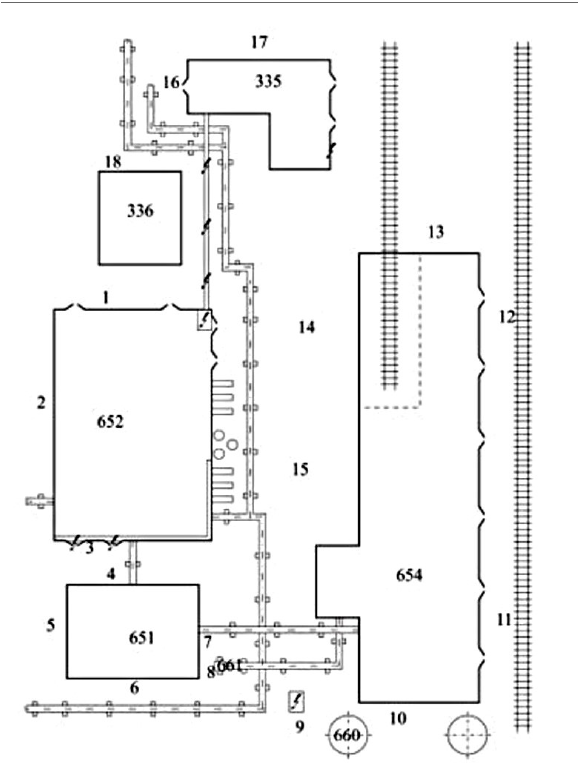
Figure 2: Scheme of points of noise measurements at industrial site of shop 4 of "KuibyshevAzot" company